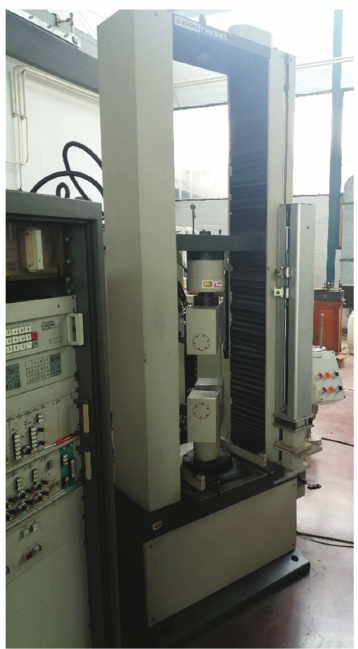
Figure 1. Instron tensile test machine used for the